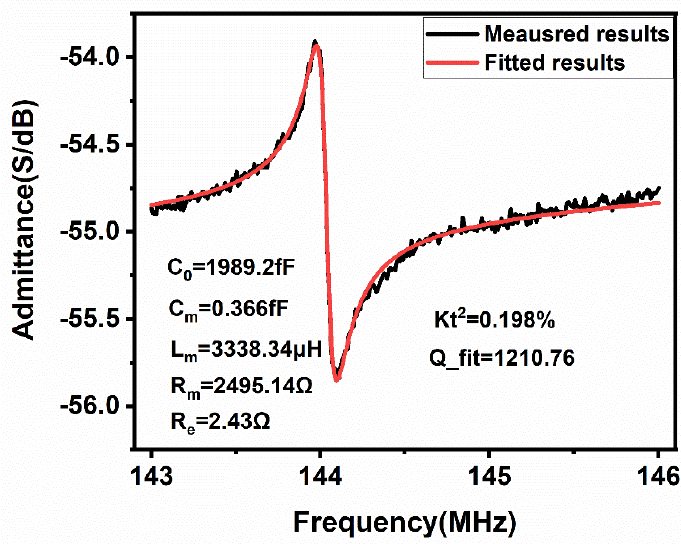
Figure 6. Results of the measured admittance versus frequency of the resonator.